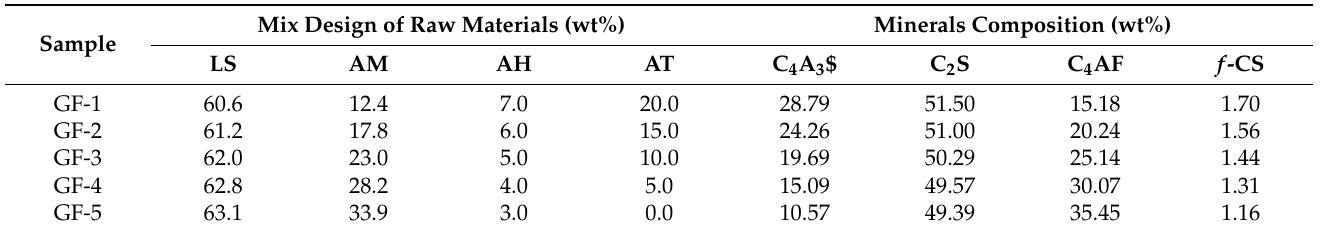
Table 3. Mix design of raw materials and theoretical mineral composition of HBSC clinker.